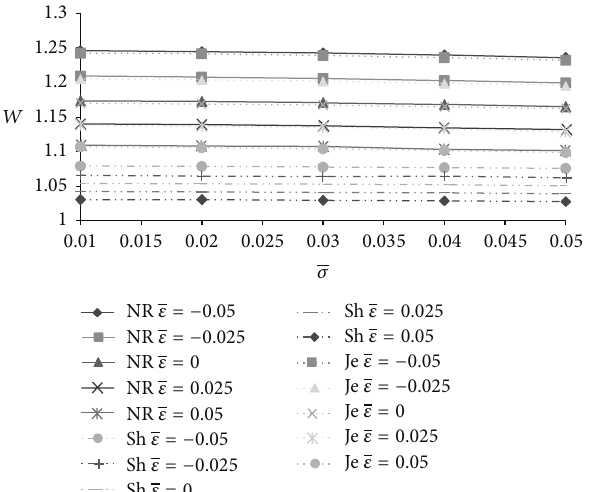
Figure 9: Variation of load carrying capacity with respect to 𝜎 and 𝛼 .